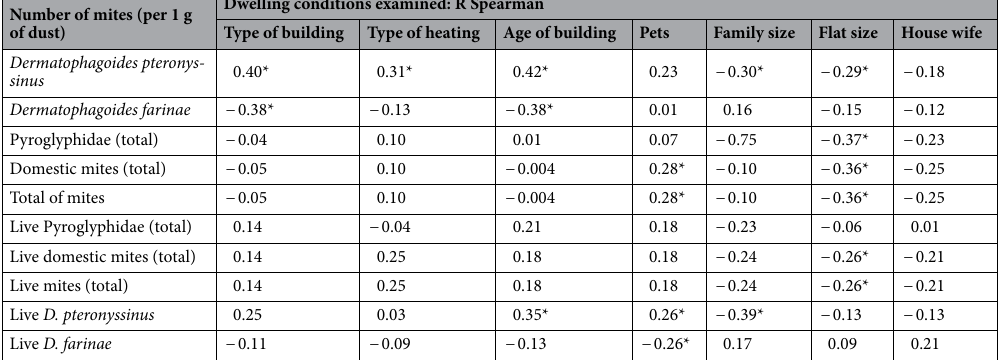
Abundance of mites. D. pteronyssinus was the most abundant species per 1 sample (Table 1), whereas D. farinae was more abundant per 1 g of dust. The mean numbers of mites per 1 g of dust were approximately 127.6, 69.9, 197.9, 209.2 and 209.3 for D. farinae, D. pteronyssinus, total pyroglyphids, total domestic mites and total mites, respectively. Whereas the mean numbers of mites per 1 sample in relation to all mite positive samples are